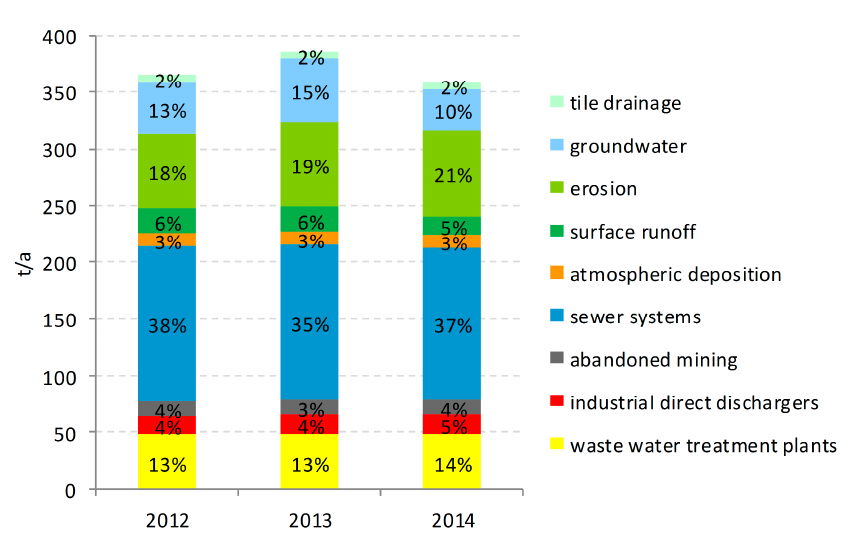
Figure 5. Relative relevance of the individual pathways for the total copper emissions into surface waters in Germany for the years 2012–2014.